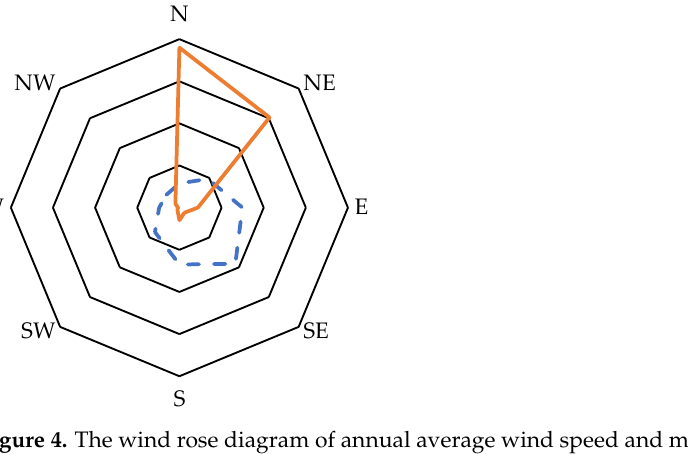
Figure 4. The wind rose diagram of annual average wind speed and maximum wind speed in the bunkering operation..